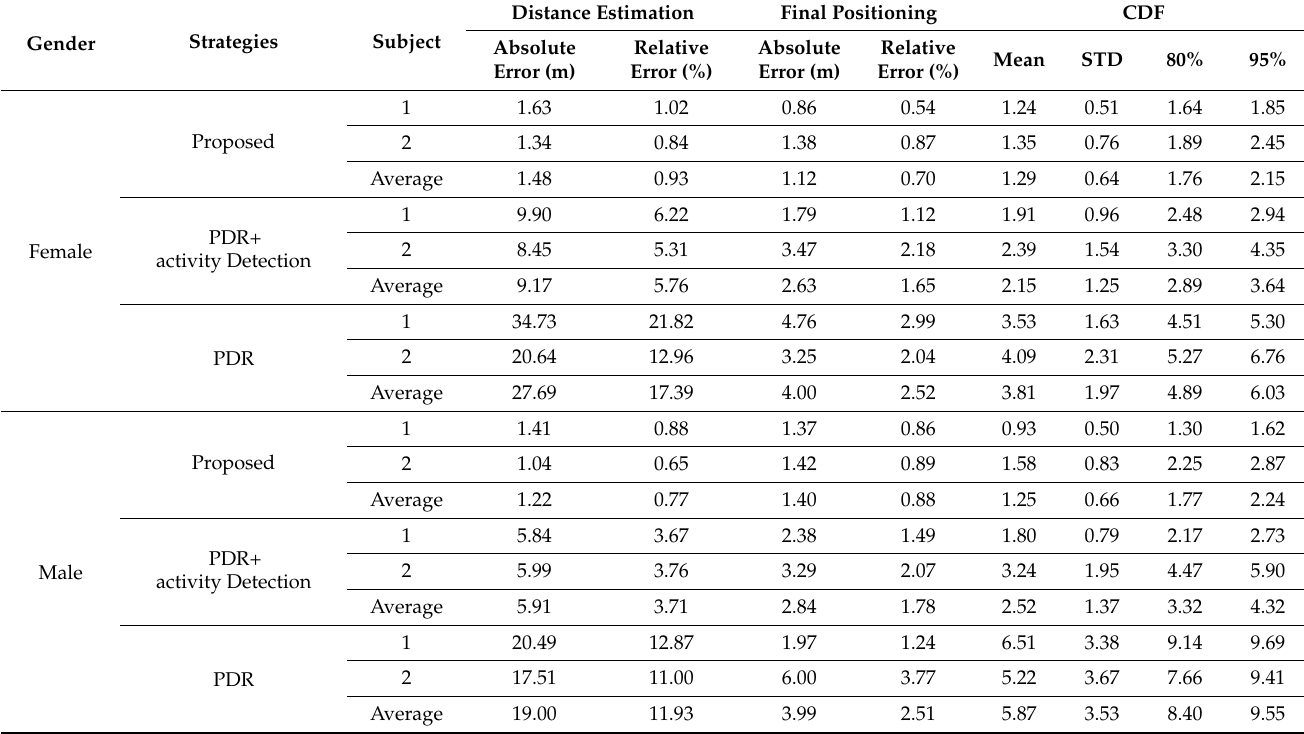
Table 12. Positioning results of the swinging